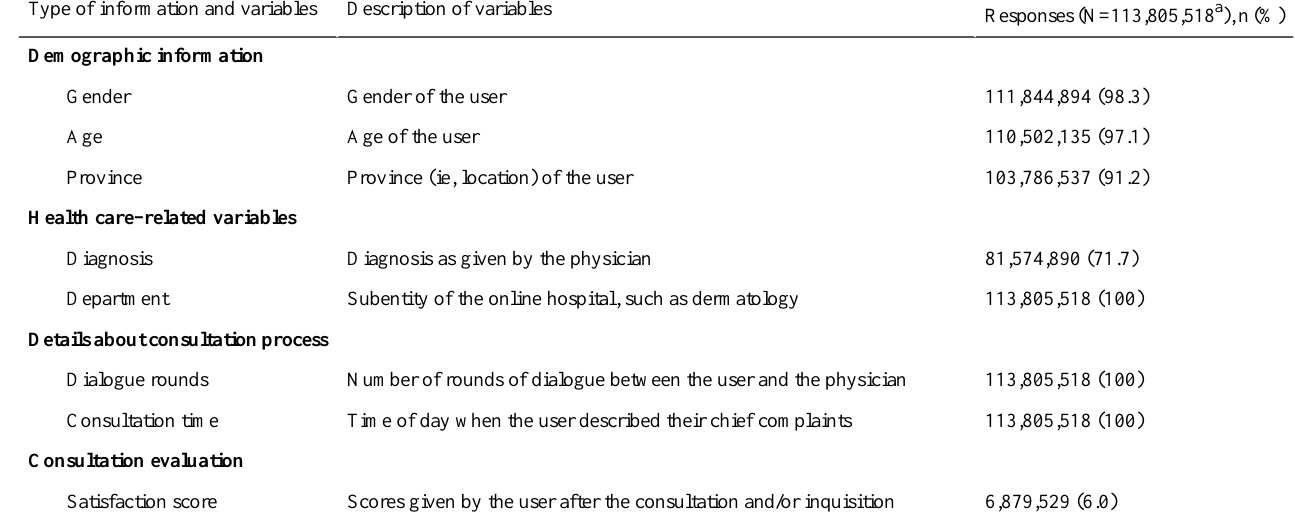
Table 1. Variables considered in this